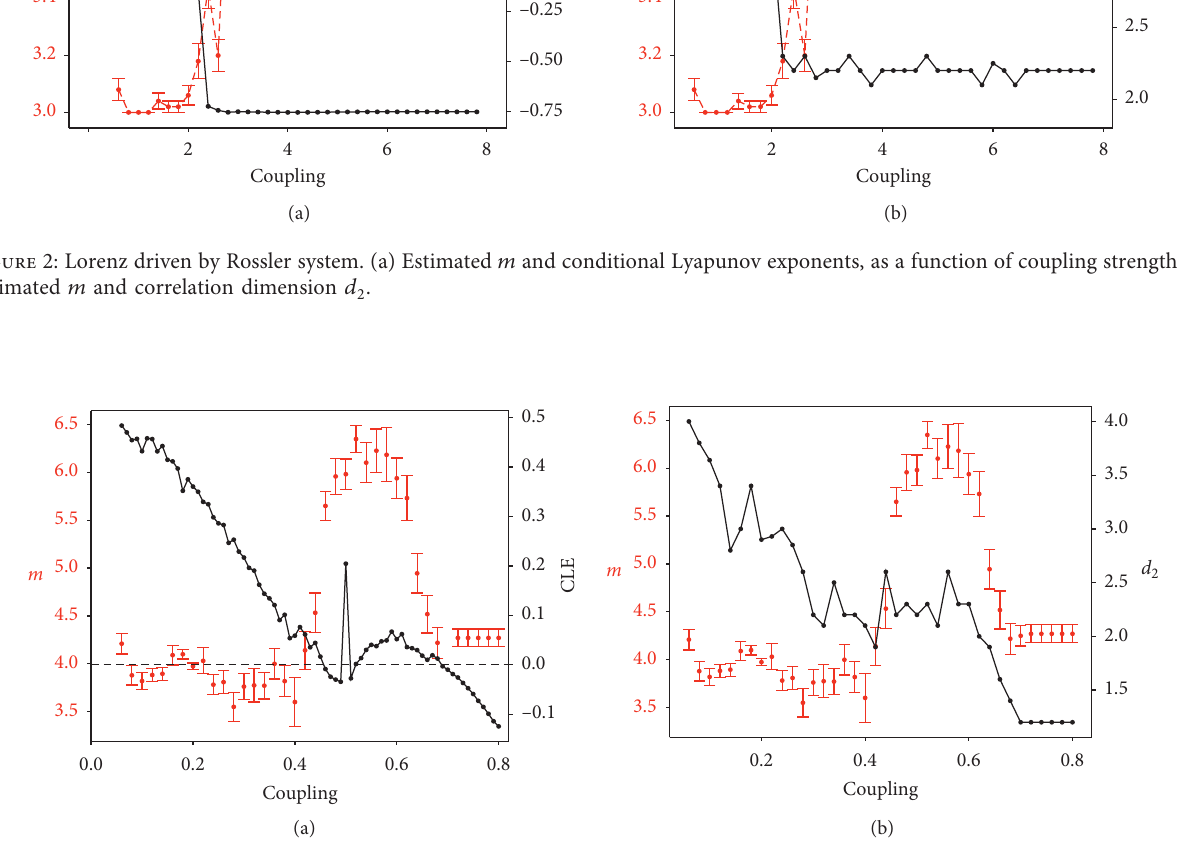
Figure 3: Coupled H´enon maps. (a) Estimated embedding m and conditional Lyapunov exponents. (b) Estimated m and correlation as a function of coupling dimension d 2